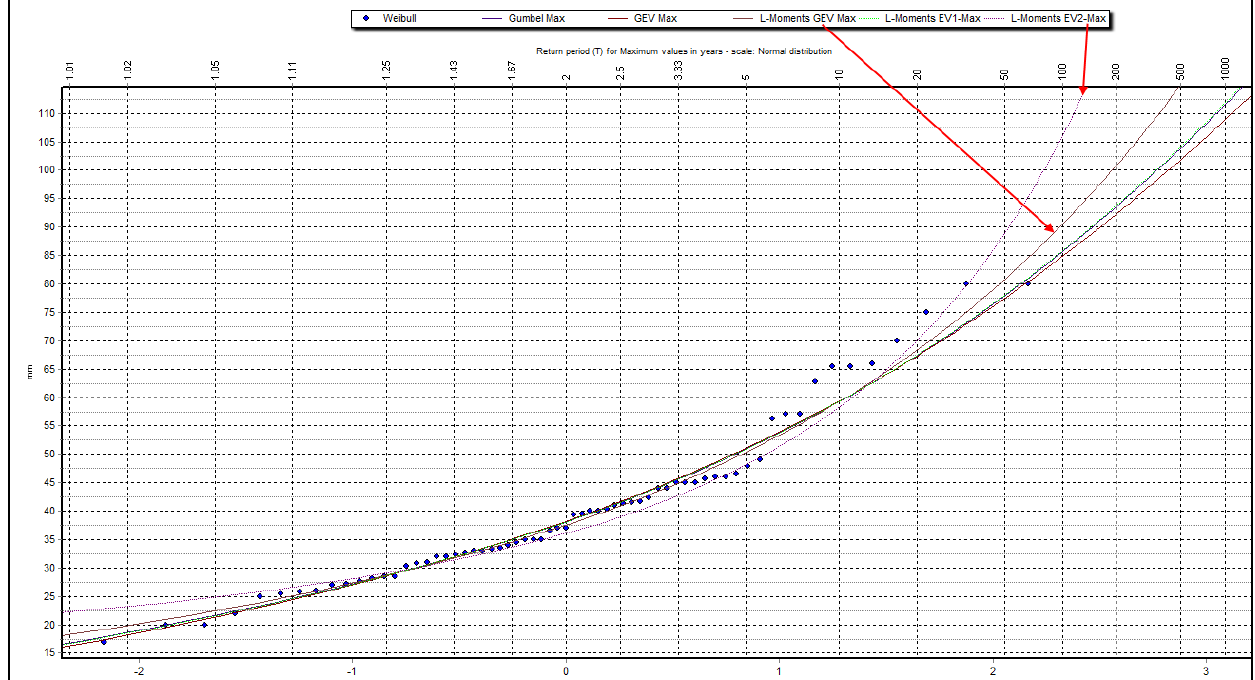
Table 4. Distributions’ performance subjected to Kolmogorov–Smirnov test.